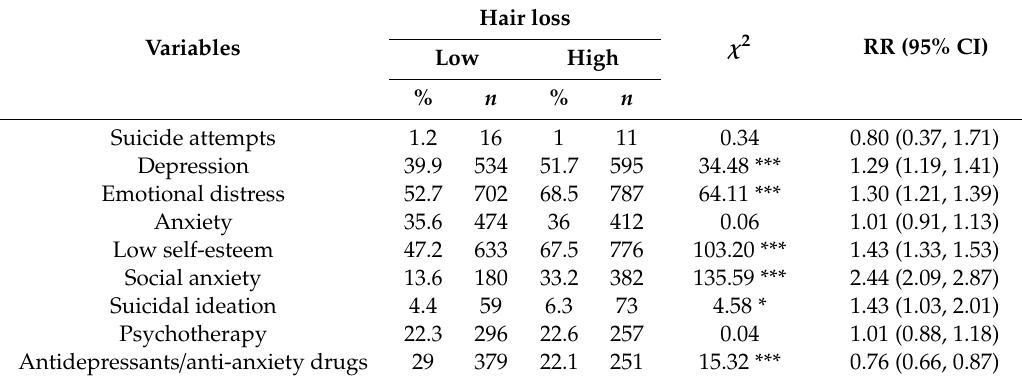
Table 2. Mental health conditions.